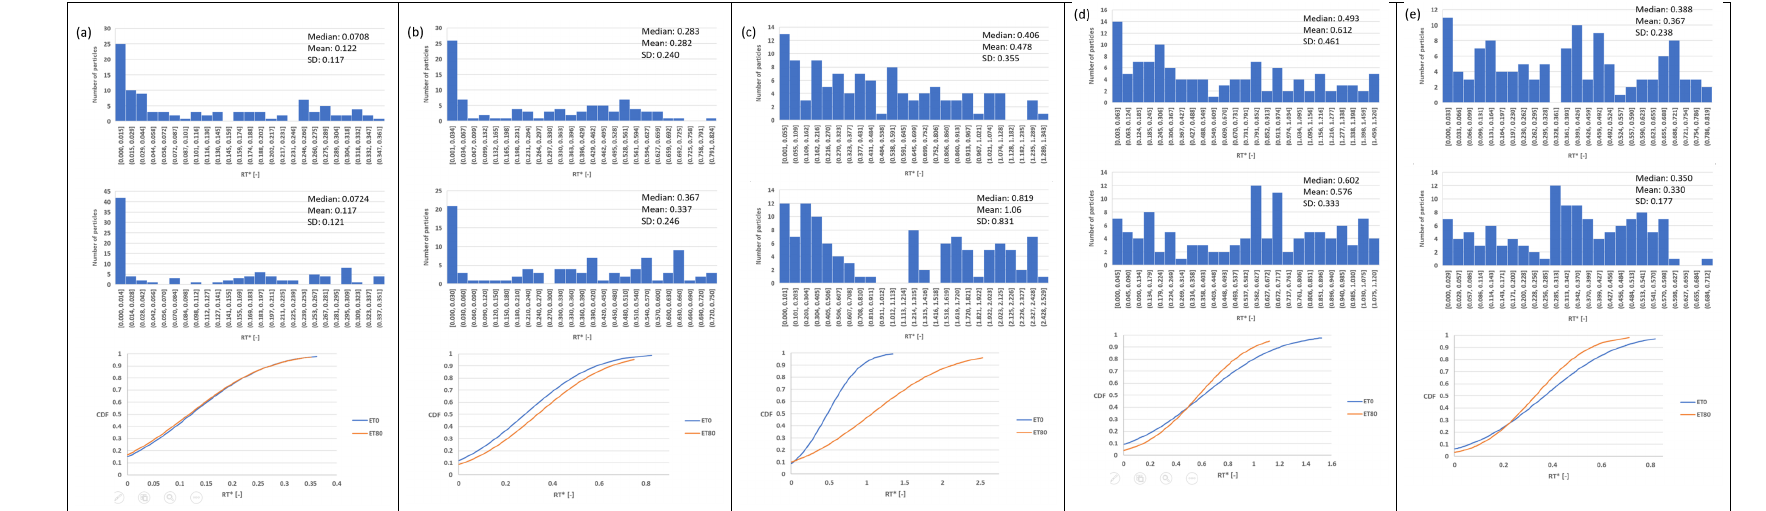
Figure 6. Residence time distributions (RTDs) from no-ET (ET0) scenarios ( top row ). RTDs from scenarios where maximum daily ET ( ET max ) is 80 mm/day ( middle row ). Comparison of cumulative RTDs from ET0 and ET80 scenarios ( bottom row ). Columns correspond to simulations where the magnitude of regional groundwater flux ( J y/x ; positive for gaining, negative for losing) was, respectively, ( a ) 2, ( b ) 1, ( c ) 0, ( d ) − 1, and ( e ) − 2.